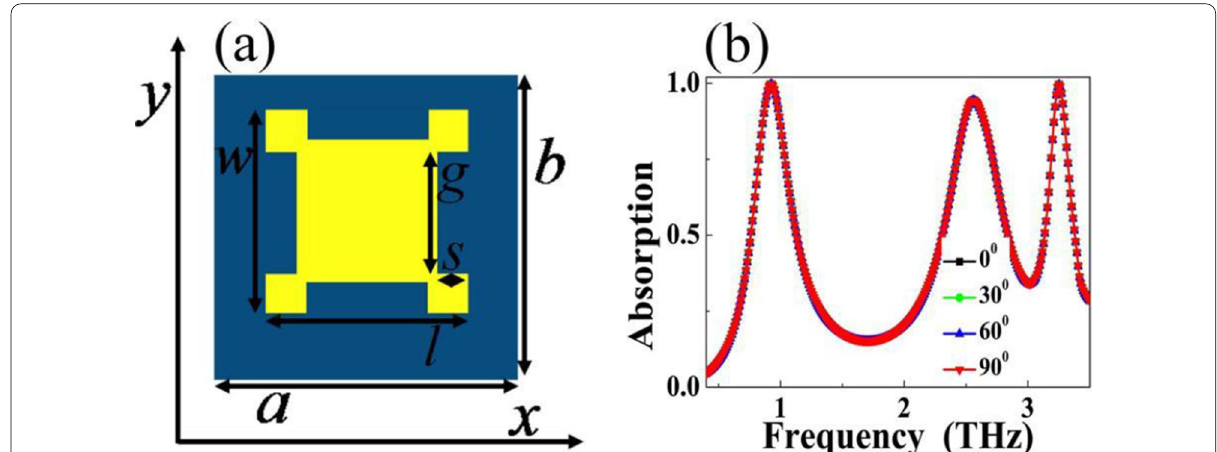
Fig. 5 a Front view of the triple‑band polarization insensitive terahertz MBLA; b Absorption spectra of the designed device as a function of